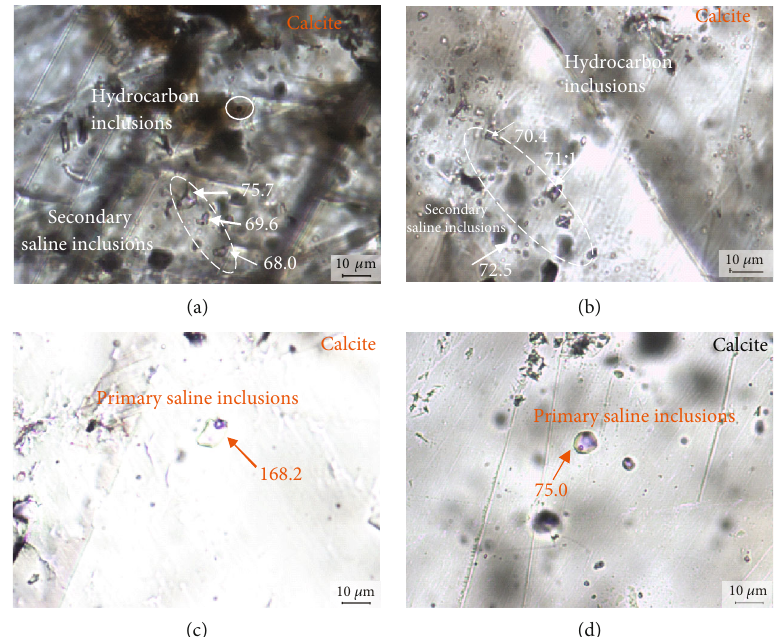
Figure 9: Microscopic characteristics of saline inclusions captured by calcite in Lucaogou Formation, Jimsar Sag: (a) the secondary saline inclusions were beaded (J10025, 3694.32m, P 2 l 1 ); (b) the secondary saline inclusions were beaded (J10024, 3634.52m, P 2 l 1 ); (c) primary saline inclusions are isolated (J10025, 3706.51m, P 2 l 1 ); (d) primary saline inclusions are isolated (J10024, 3634.52m, P 2 l 1